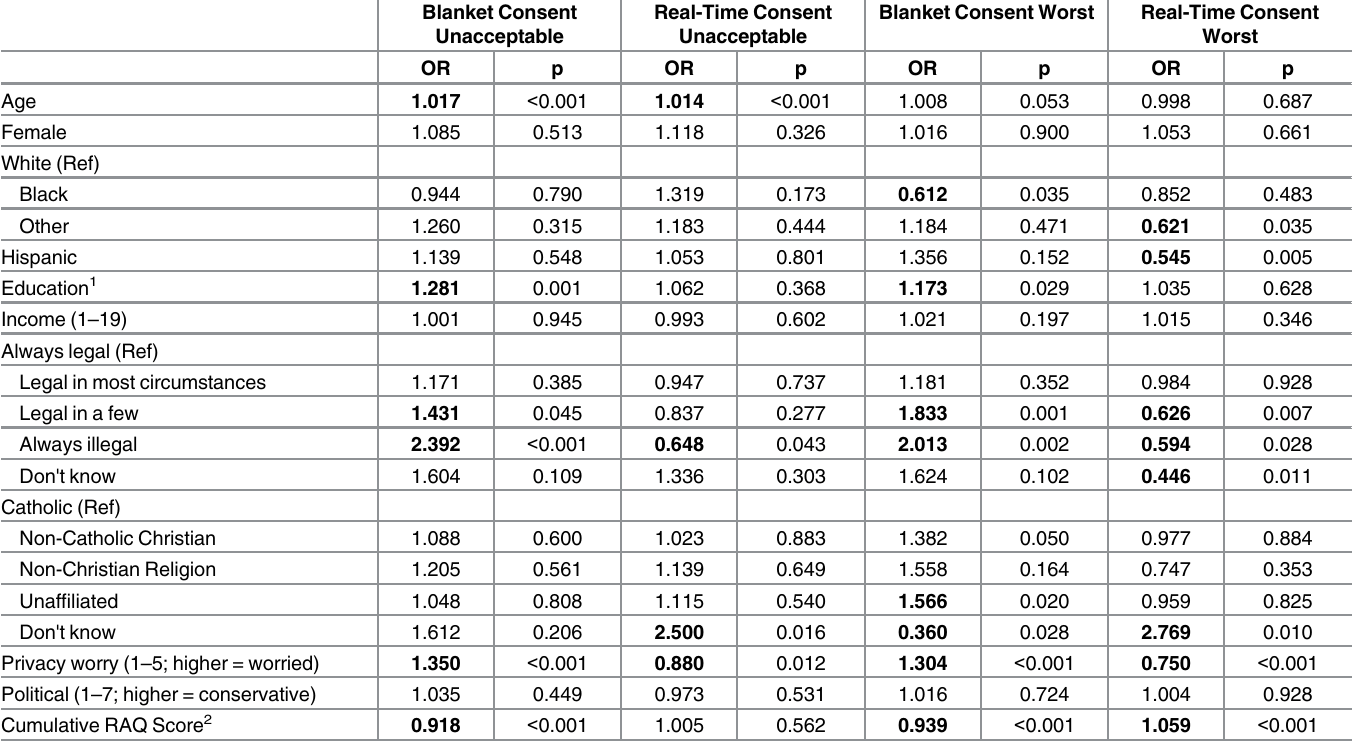
Table 4. Logistic regression predicting preferences for blanket or real-time specific consent